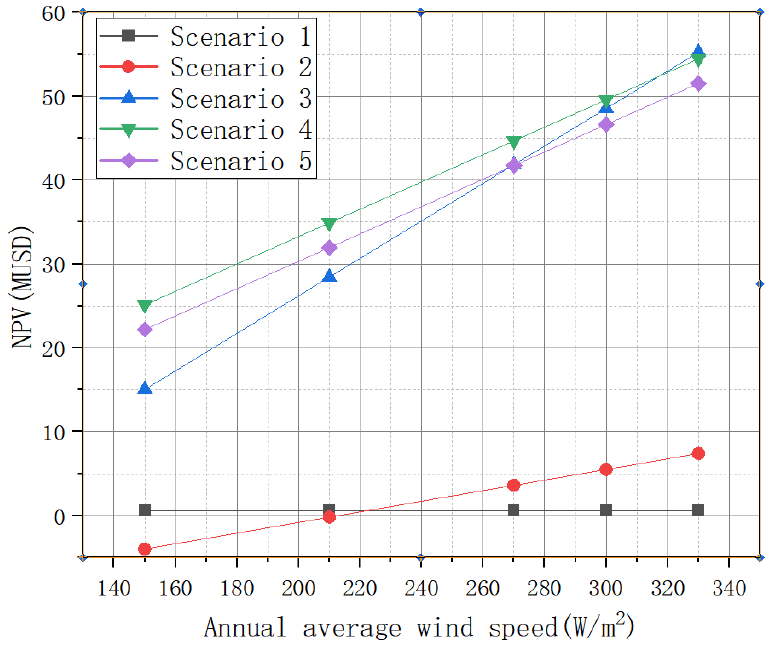
Figure 14. NPV of the model under different wind speed